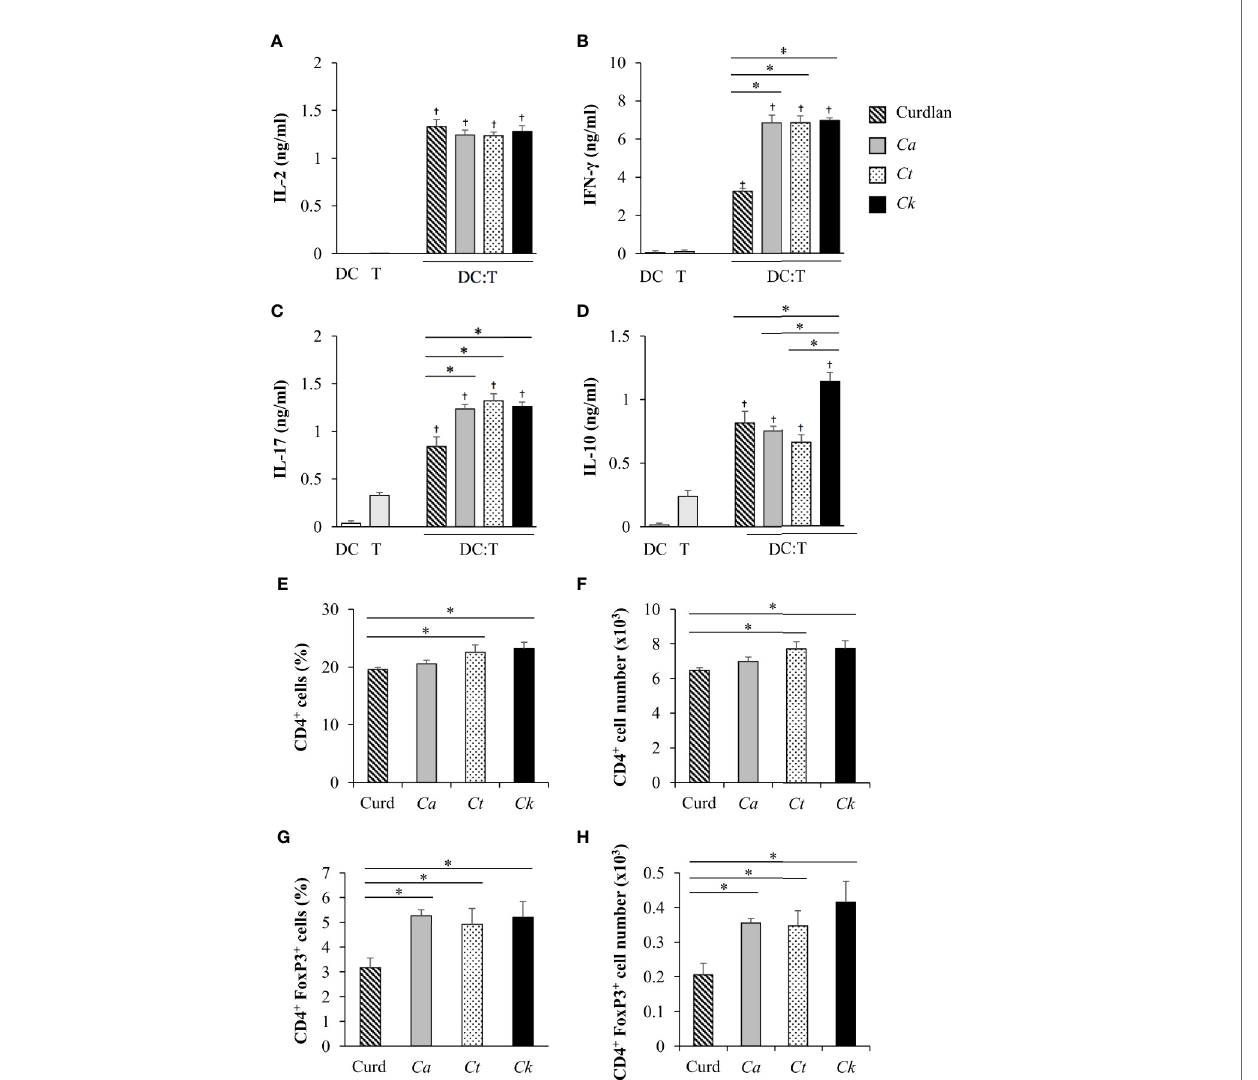
FIGURE 6 | Effects of C. krusei b -glucans-stimulated bone-marrow derived dendritic cell (BMDC) on cytokine production of T cells. BMDCs were stimulated with 25 µg/ml of curdlan and b -glucans isolated from C. albicans , C. tropicalis , and C. krusei for 24 h. The stimulated BMDCs were co-cultured with murine splenic T cells at a DC:T cell ratio of 1:10 in the presence of soluble anti-mouse CD3 monoclonal antibody (30 ng/ml). Levels of T cell cytokines were assessed in culture supernatants. (A) IL-2 levels were measured following 24 h of co-culture. (B) IFN- g , (C) IL-17, and (D) IL-10 levels were measured following 72 h of co-culture. BMDCs alone and T cells alone were incubated with the soluble anti-CD3 antibody as negative controls. n = 3; the percentages and numbers of CD4 + T cells and CD4 + FoxP3 + were determined following 72 h of co-culture by fl ow cytometry. n = 3; (E) percent and (F) number of CD4 + cells, (G) percent, and (H) number of CD4 + FoxP3 + cells. data are representative of two independent experiments. † p <0.05 compared with negative controls, * p <0.05. DC, BMDCs; T, T cells, Ca , C. albicans ; Ct , C. tropicalis ; Ck , C. krusei